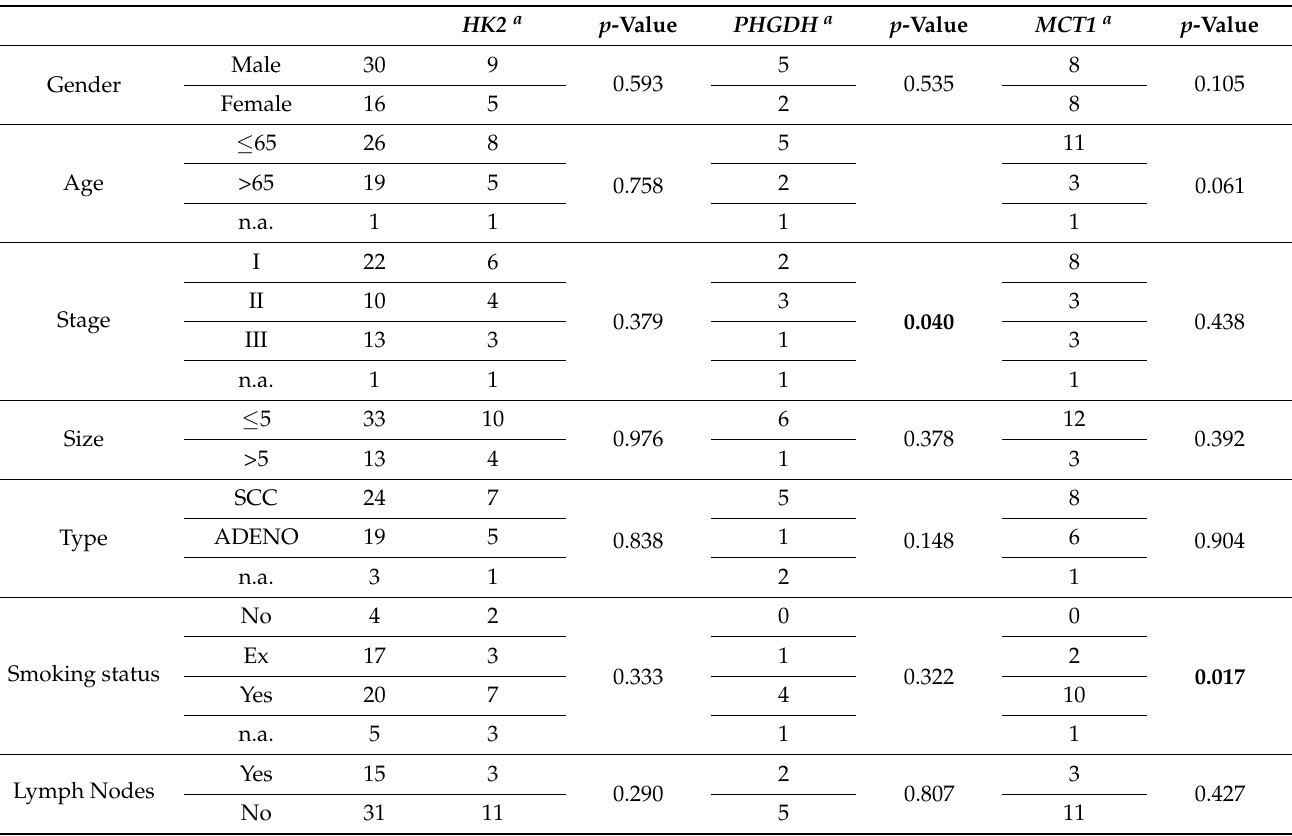
Table 1. Clinicopathological characteristics of